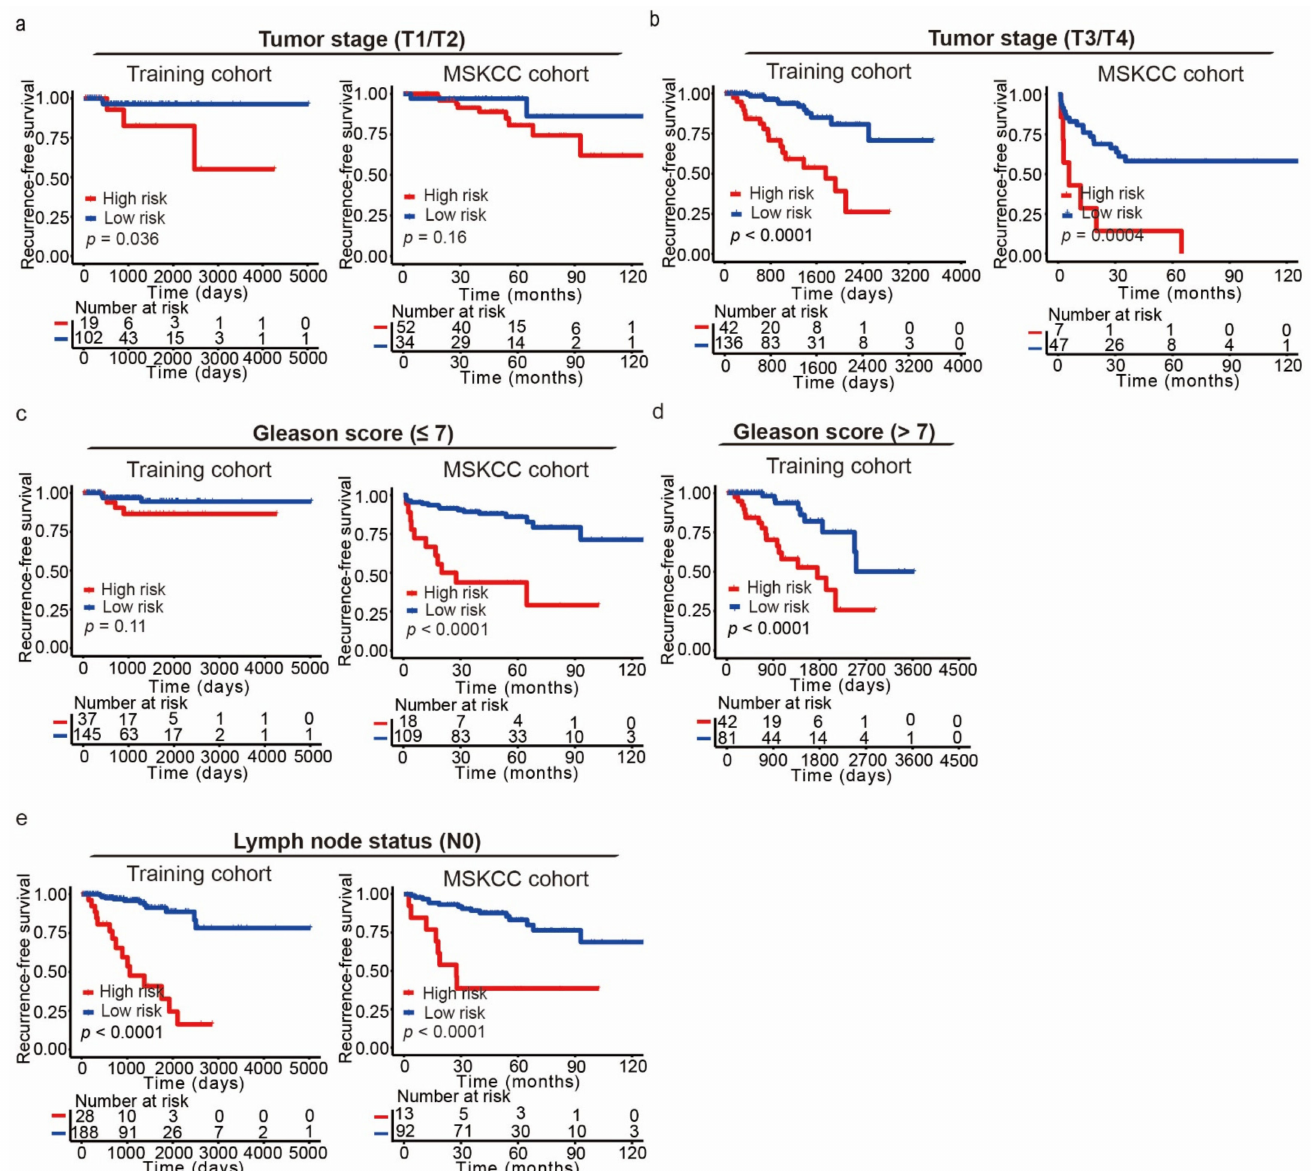
Figure 10. Kaplan–Meier curves of recurrence-free survival (RFS) according to the CRPCPS score in patients stratified by pathological tumor stage, lymph nodes status, and Gleason score. Kaplan–Meier curves were applied to patients with lower tumor stage (T1/T2) ( a ), higher tumor stage (T3/T4) ( b ), lower Gleason score ( ≤ 7) ( c ), higher Gleason score (>7) ( d ), and without lymph node metastasis (N0) ( e ), in the training cohort (left panel) and the MSKCC cohort (right panel). The tick marks on the Kaplan–Meier curves represent the censored subjects. The two-sided log-rank test was used to determine differences between the two